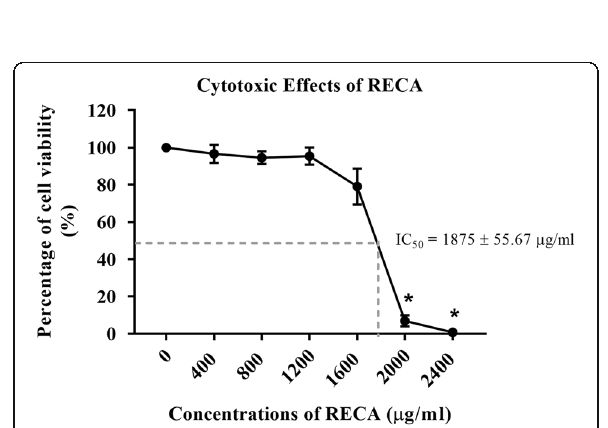
Fig. 3 Dose-dependent effects of RECA on hWJMSCs. The viability of hWJMSCs was reduced after supplementation with RECA for 24 h. RECA at 2000 μ g/ml and 2400 μ g/ml significantly inhibited the growth of hWJMSCs, p < 0.05 ( n =